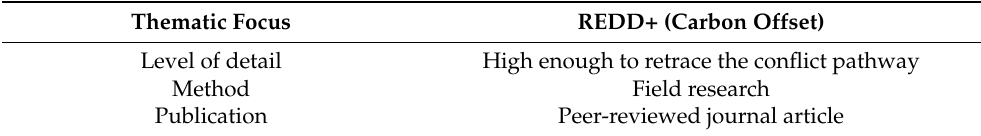
Table 1. Selection criteria for the case